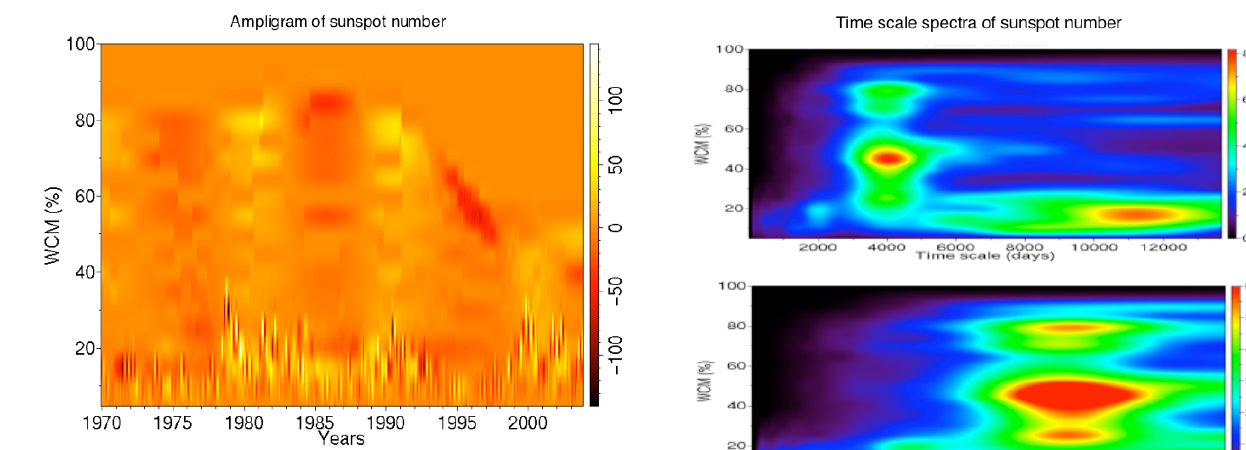
Fig. 4. The ampligram of the sunspot number from 1970 to 2004. WCM ( % ) stands for the fraction of the maximum of the wavelet coefficient magnitude.